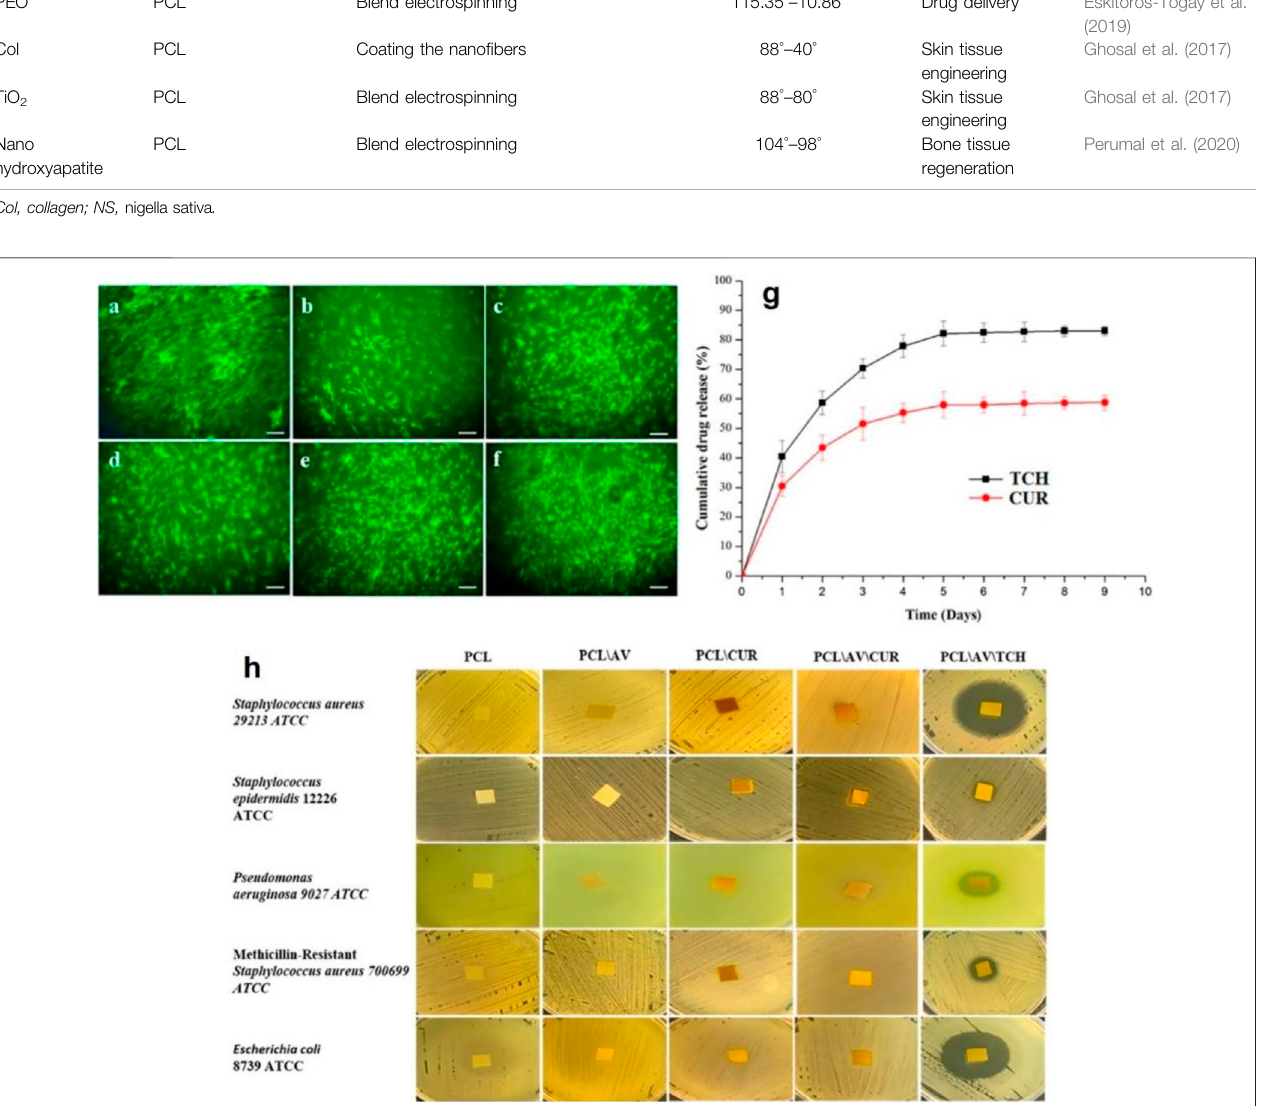
Frontiers in Chemistry |